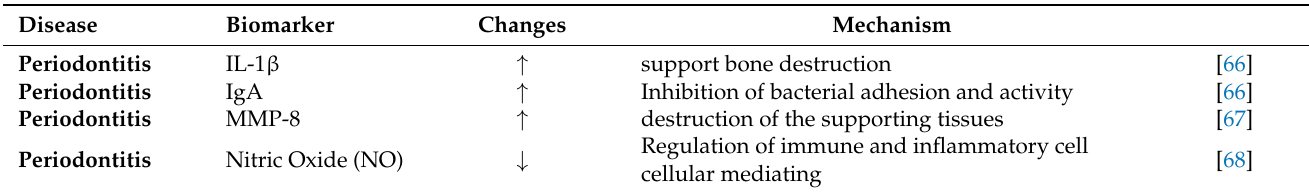
Table 1. Change in concentration in saliva of biomarkers of periodontal